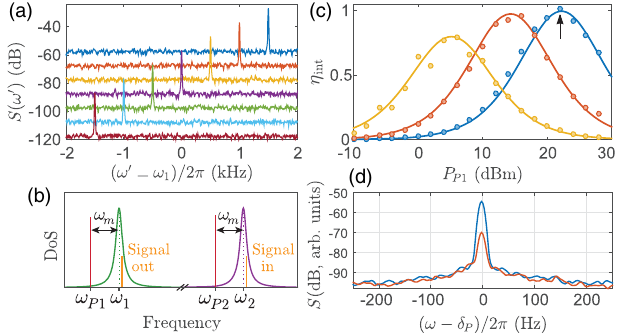
FIG. 4. Frequency conversion without amplification. (a) Output spectrum S ð ω 0 Þ (arbitrary units, each curve offset by 10 dB) showing the frequency-converted output signal ω 0 several input frequencies ω ration. (c) Conversion efficiency on resonance ( ω with fitted theory (see text), for P (red), and 22 dBm (blue), in the same units as P indicates data shown in (a). (d) Coherence of conversion. Shown are spectra of the mixed-down pump tone δ destructive interference of δ